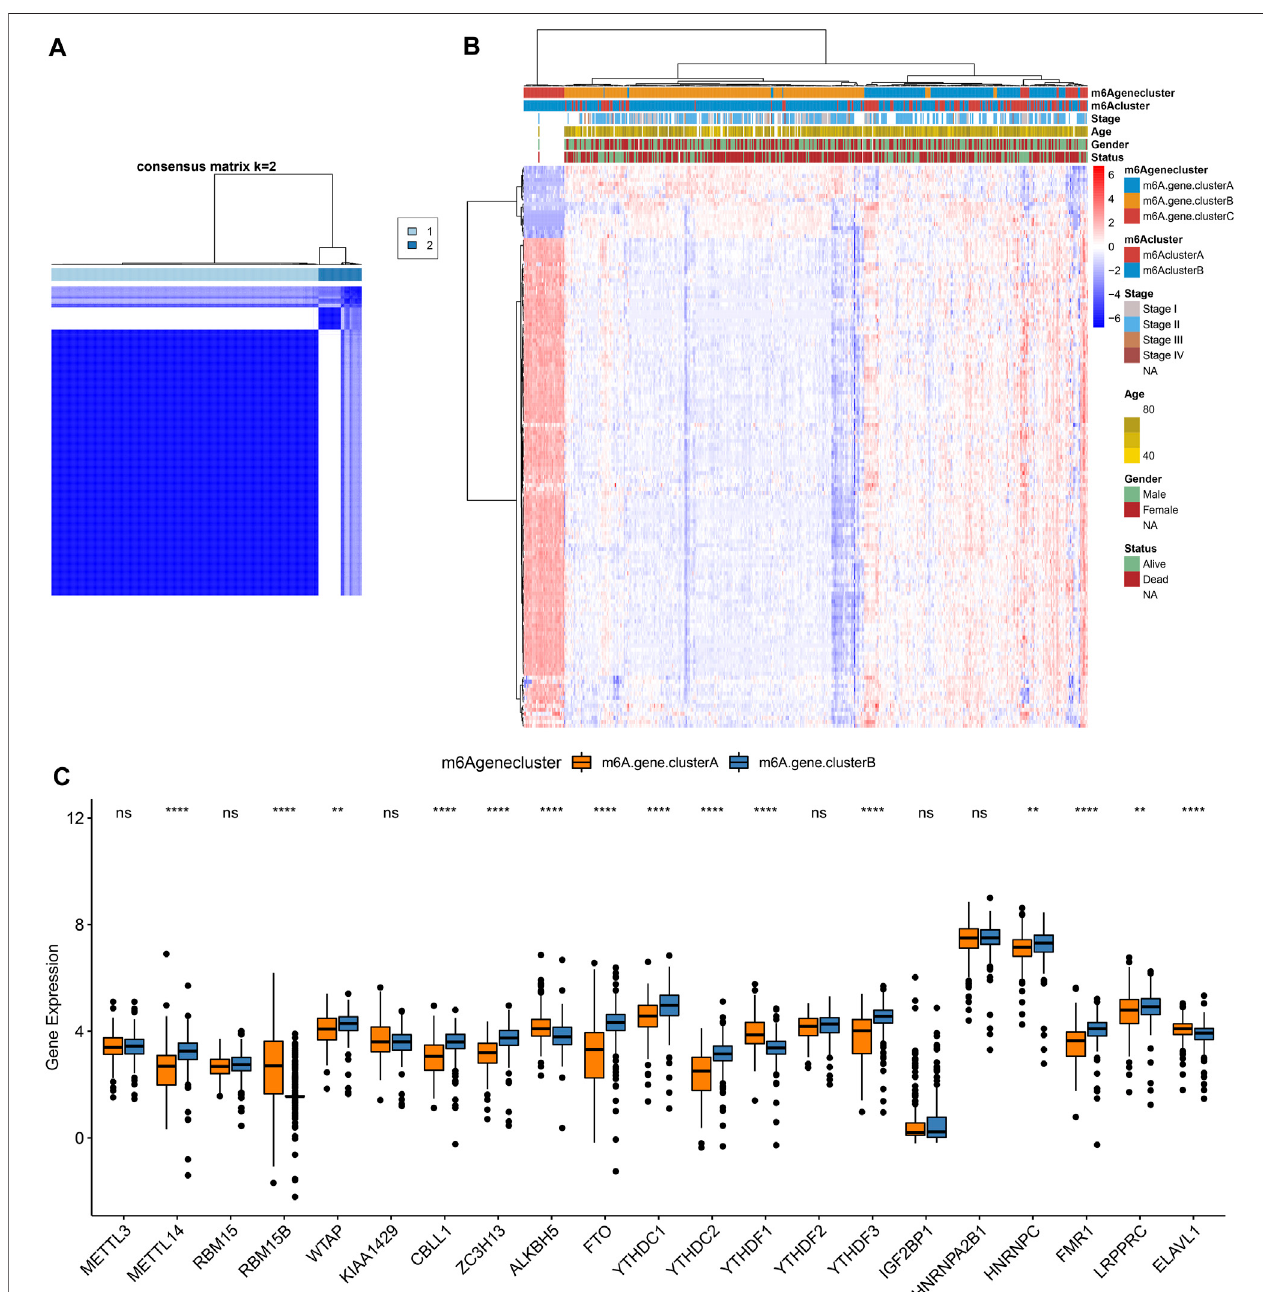
FIGURE4| Constructionofm 6 Ageneclustersinpancreaticcancer. (A) Consensusmatrixheatmapwhen k (cid:1) 2. (B) Heatmapoftwom 6 Ageneclustersandexpression patterns of m 6 A-related genes. (C) Box plot of expression patterns of 21 m 6 A regulators in m 6 A gene cluster A and B. Ns: not signi fi cant; ** p < 0.01; **** p <